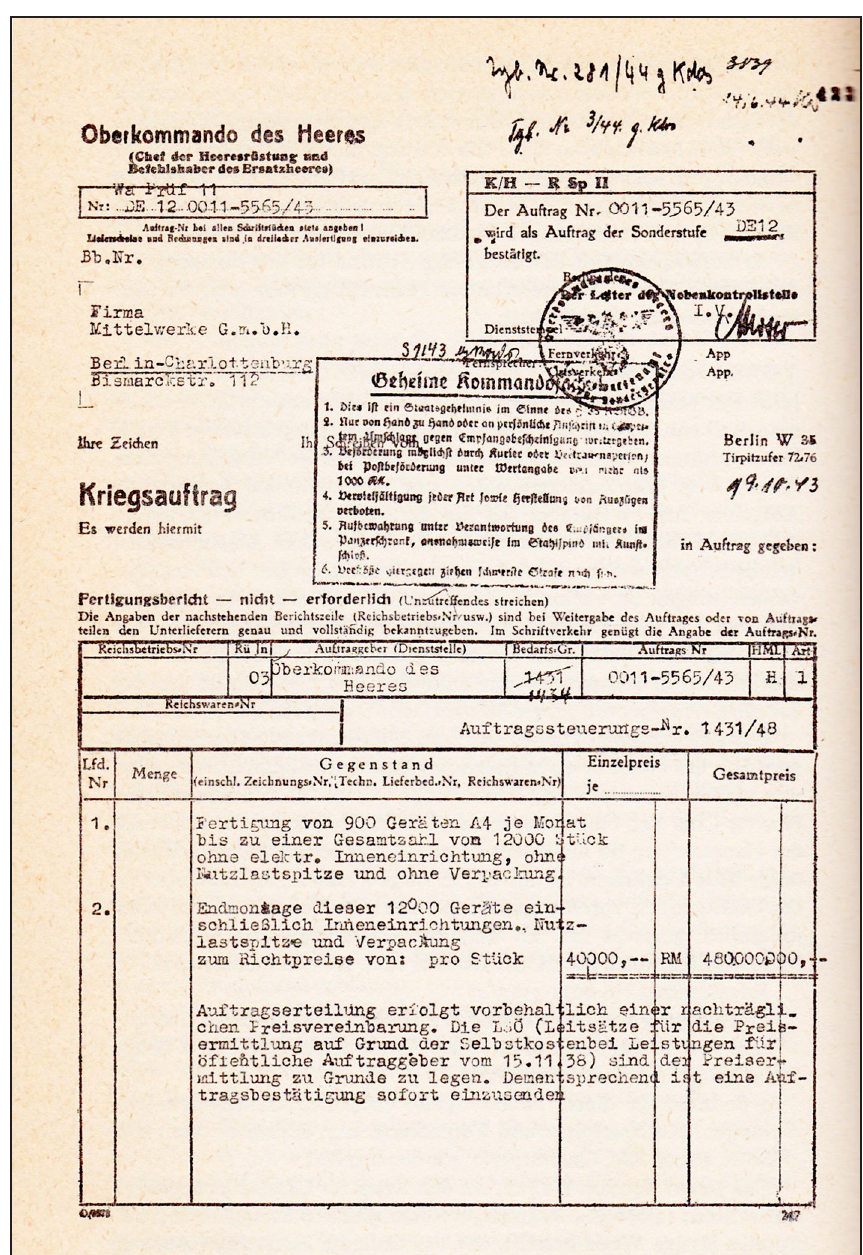
Figure 4: Document 0011-5565/43. Initial order for 900 V-2s per month (at a price of 40,000 reichsmark per rocket) up to a total number of 12,000 rockets (Irving, 1965: